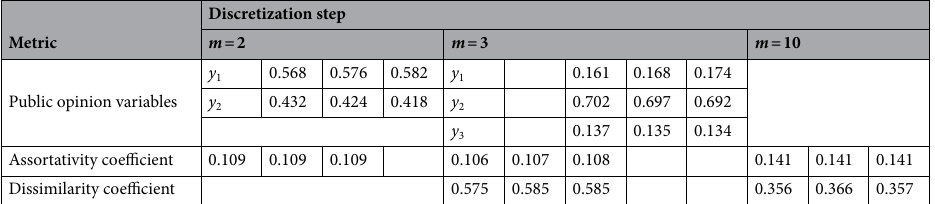
Table 1. Values of metrics M1 – M3 drawn from dataset. The dissimilarity coefficient in the case of the binary opinion space is not useful and, therefore, we do not calculate it. The dynamics of public opinion variables in the case of the tenfold opinion space are too massive—one can find this information in Ref. 63 if necessary. Opinion distribution y 1 = 0.161, y 2 = 0.702, y 3 = 0.137 that demonstrates public opinion in the first opinion snapshot is presented in Fig. 1 (as the blue